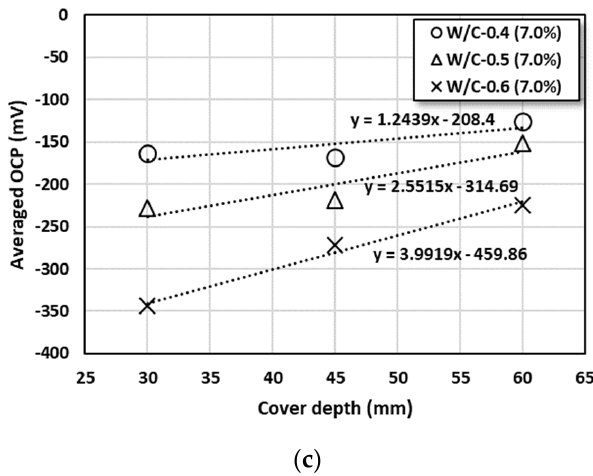
Figure 11. Averaged open-circuit potential (OCP) with increasing chloride concentration: ( a ) 0.0%, ( b ) 3.5%, and ( c ) 7.0%.